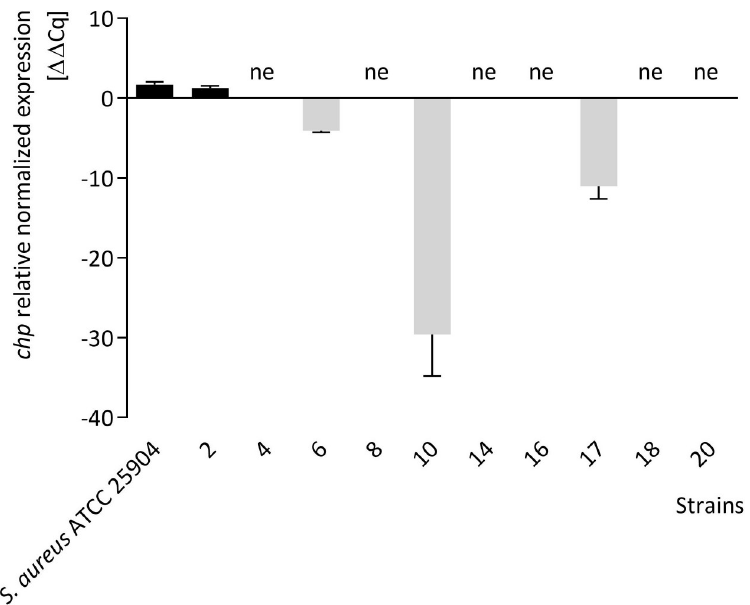
Fig 1. Relative expression level of the chp gene in Staphylococcus aureus strains cultured on Mueller-Hinton agar (MHA) supplemented with 1% (v/v) Tween 80 and trans -anethole (TA) at the subinhibitory concentration. The relative gene expression levels presented in the figure are a result of comparing the expression levels on the MHA (control–medium A) with MHA supplemented with TA (medium C). Values > 0 indicates upregulation (black bars); values < 0 indicates down-regulation (gray bars); ne–no expression. Data are shown as the mean ± standard deviation.